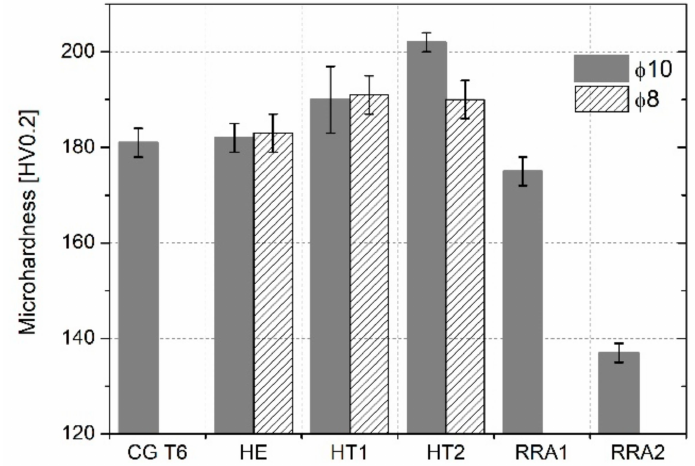
Figure 11. Microhardness results of the samples.